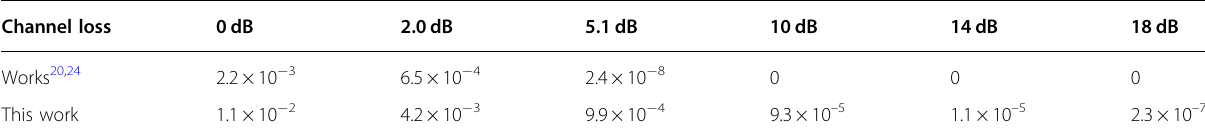
Table 2 Evaluation results of secrecy capacity with several typical channel loss Channel loss